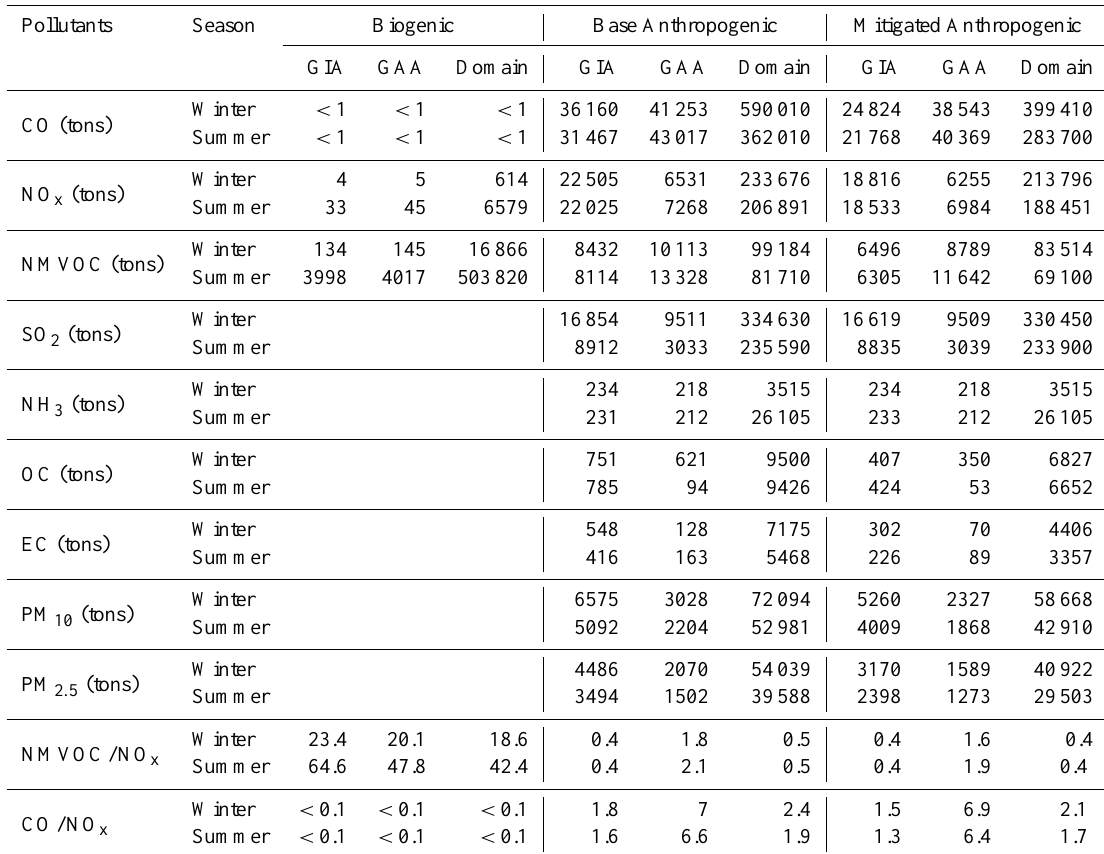
Table 1. Base case and mitigated anthropogenic (including shipping) and biogenic emissions (including emissions from soils, in tons) of Greater Istanbul (GIA) and Greater Athens (GAA) areas integrated over the simulation periods of winter (December 2008) and summer (July 2008). OC and EC emissions are emitted in the fine fraction in the CMAQ model. NMVOC/NO x and CO/NO x are molar ratios. Areas corresponding to land surfaces in the model grid boxes shown in Fig. 1 (inner frames) are GIA: 5286 km 2 , GAA: 5142km 2 and Domain: 843220km 2